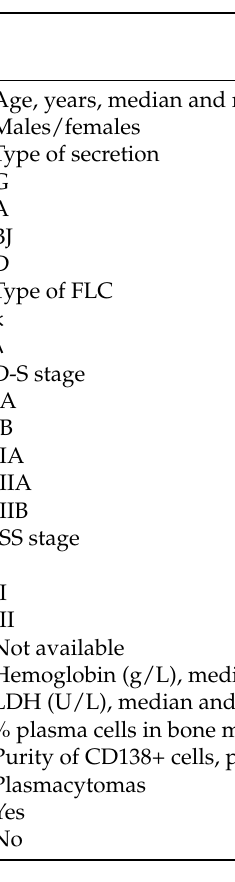
Table 1. Characteristics of MM